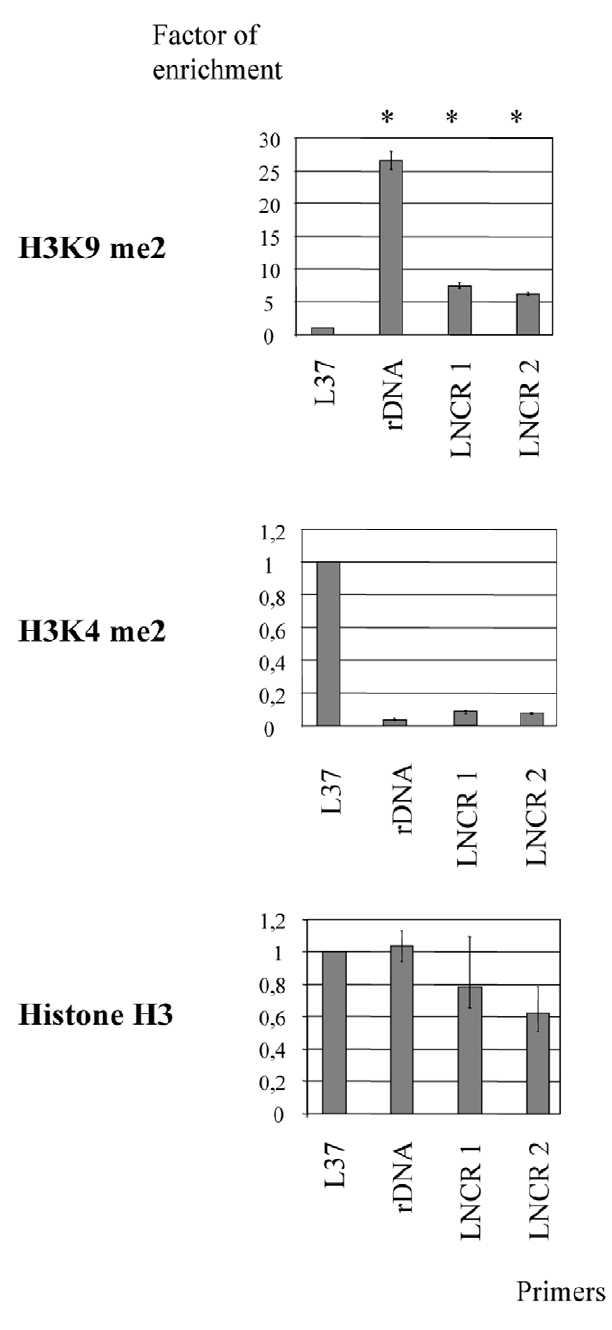
Figure 6. Chromatin organization at the genomic TE-LNCR copies. Presence of histone H3 and histone H3 modifications (H3K9me2 and H3K4me2) at TE-LNCR genomic copies done by ChIP- qPCR. The L37 ribosomal gene was used as a positive control for euchromatic regions and rDNA as a positive control of heterochromatic regions. The chromatin organization at TE-LNCR genomic copies was followed with two pairs of primers (LNCR 1 and 2). Error bars indicate standard deviations over three independent experiments. Asterisks indicate statistically significant enrichment of heterochromatic marker over the control region L37 (p , 0.05). P-values were calculated using the Student’s t-test. doi:10.1371/journal.pone.0024746.g006 S. frugiperda LNCR rasiRNAs do not have a prominent nucleotide motif. This is in contrast to some previously described rasiRNAs that interact with the Piwi protein [12,23]. The unusual features of